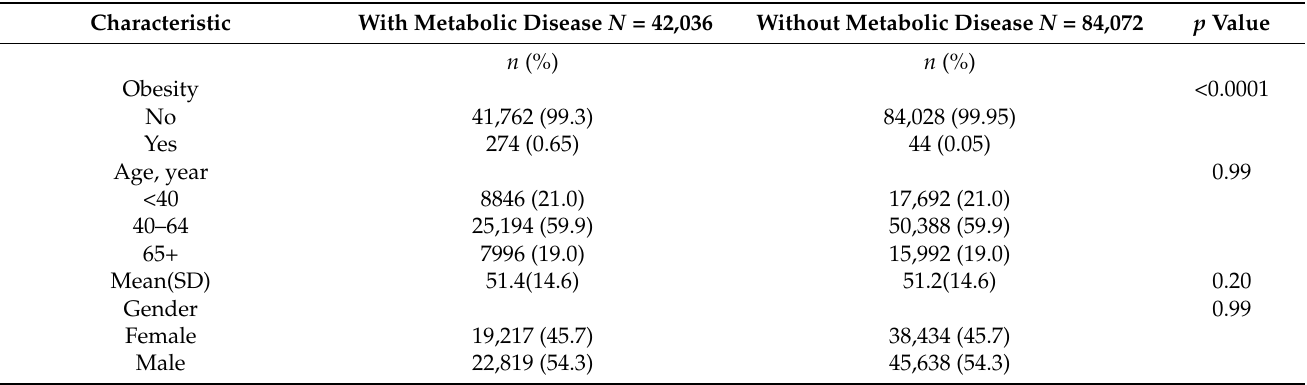
Table 1. Comparison of demographic characteristics, comorbidities and drug may induce glaucoma between cohorts with and without any metabolic disease (diabetes, hypertension,